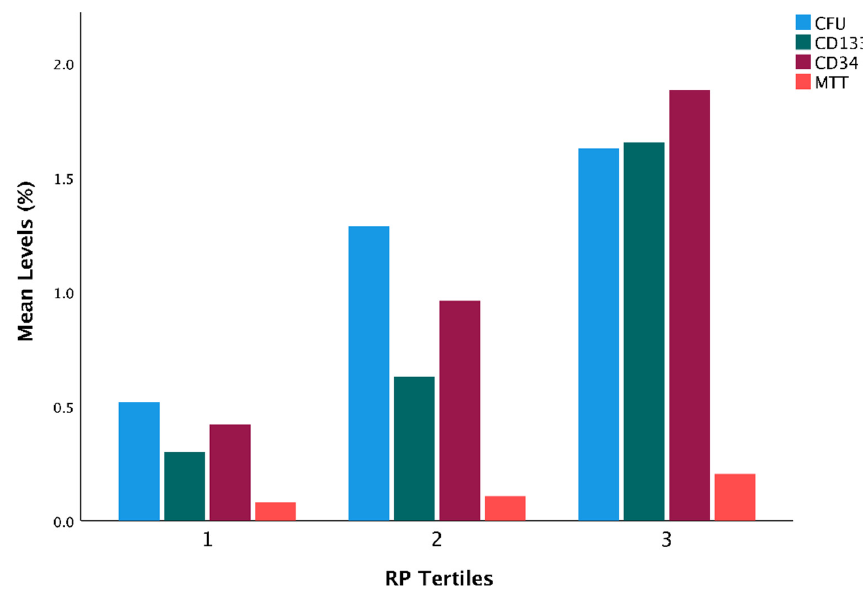
Figure 3 and Table 4 show a strong positive correlation for the four EPC markers and RP quantity. In the continuous analysis, there was a strong positive correlation between reticulated platelet quantity and MTT at baseline (R = 0.766 and R 2 = 0.586, p < 0.001). There was also a strong positive correlation between reticulated platelet quantity and CD34 quantity (R = 0.602, and R 2 = 0.362 p < 0.001), CD133 quantity (R = 0.666 and R 2 = 0.4430, mide; RP = reticulated platelet. p < 0.001) and CFU levels (R = 0.437 and R 2 = 0.191, p < 0.001).